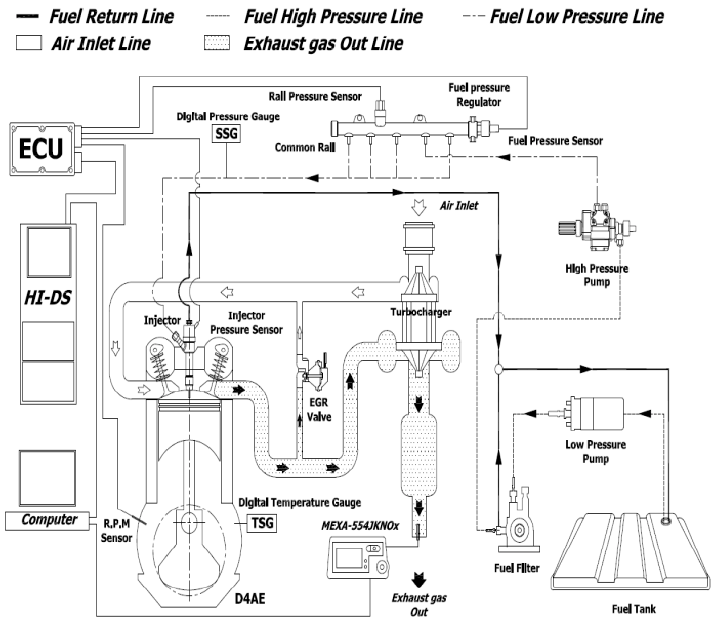
Figure 1. Configuration of common rail diesel engine. Table 1. Specifications of common rail diesel engine.